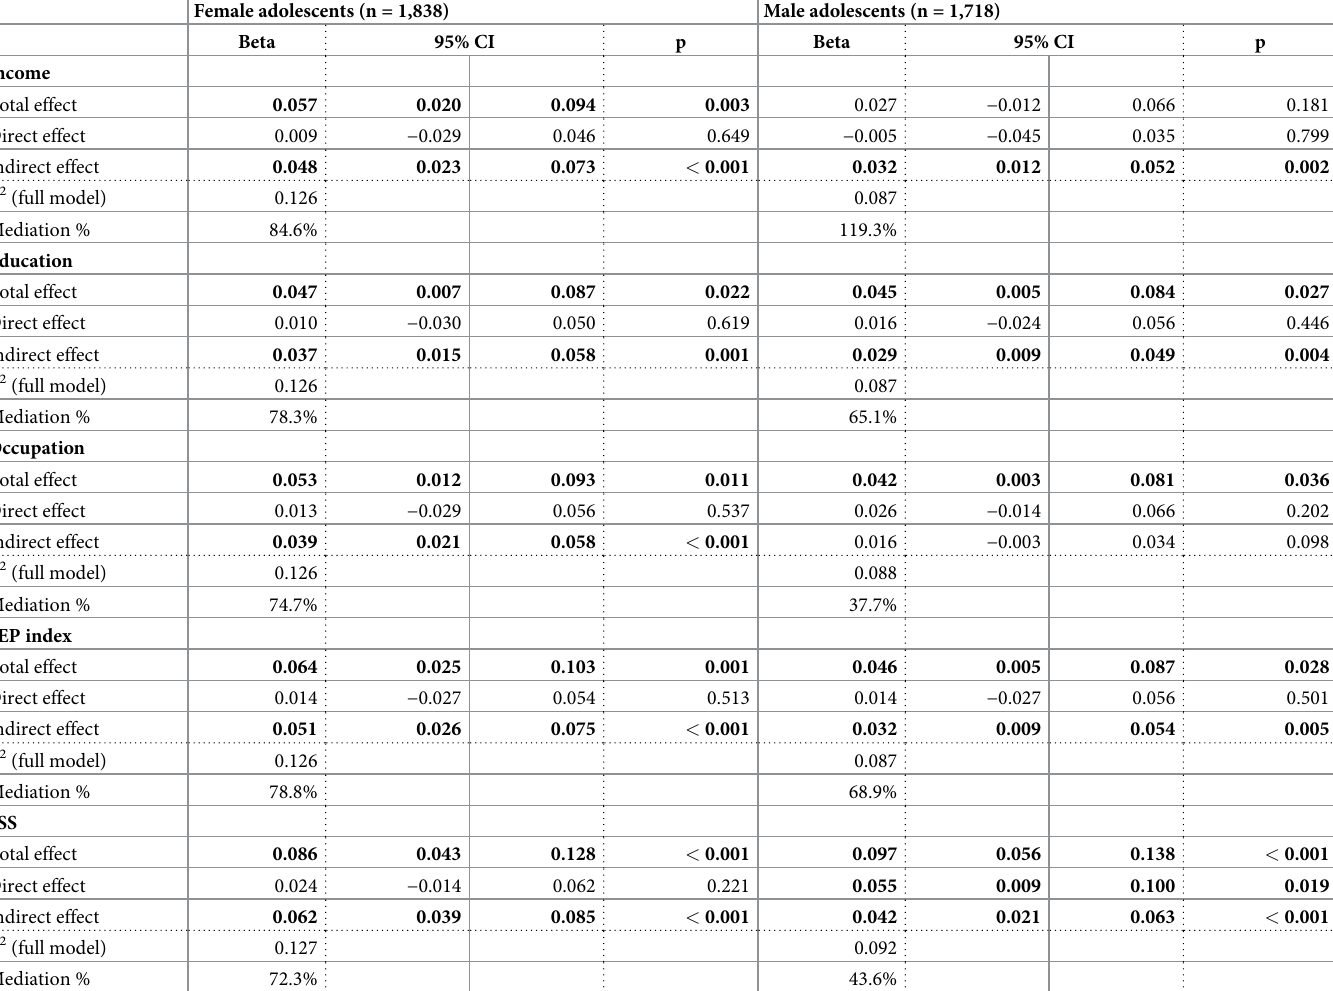
Table 2. Decomposition of the total effects of SEP indicators on self-rated health into direct and indirect effects by familial determinants in female and male adoles- cents (linear regression, KHB method). Female adolescents (n = 1,838) Male adolescents (n = 1,718)